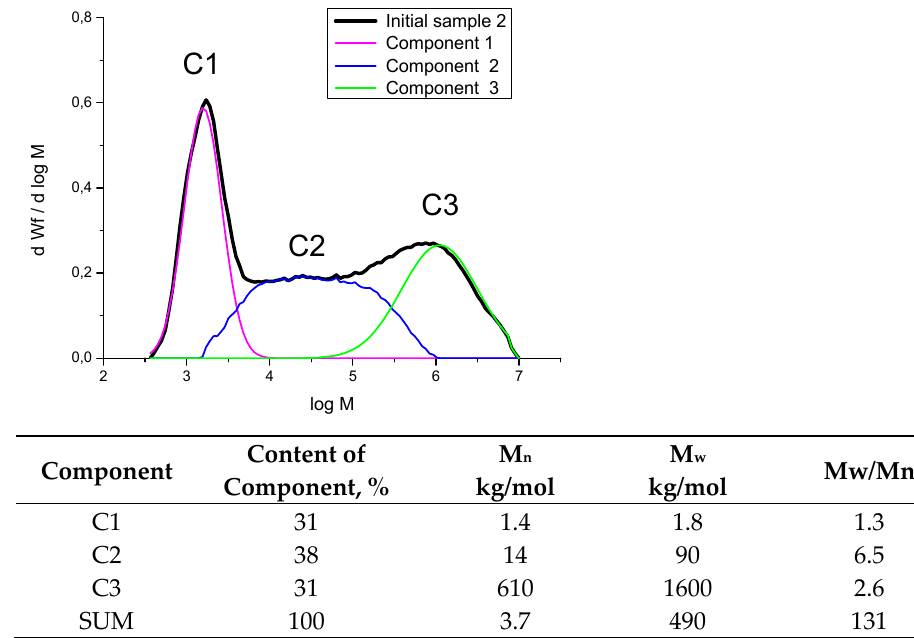
Figure 3. MWD curves for polymer samples produced in exps. 1 and 2 in Table 1.